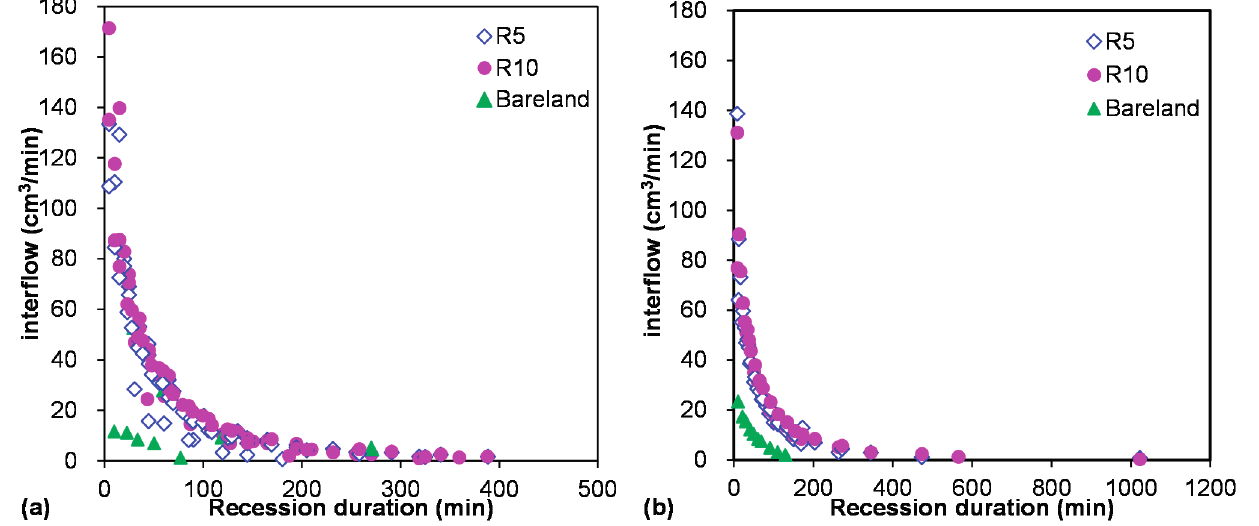
Figure 4. The recession process of interflow for the three plots under ( a ) constant rainfall intensity and ( b ) variable rainfall intensity.